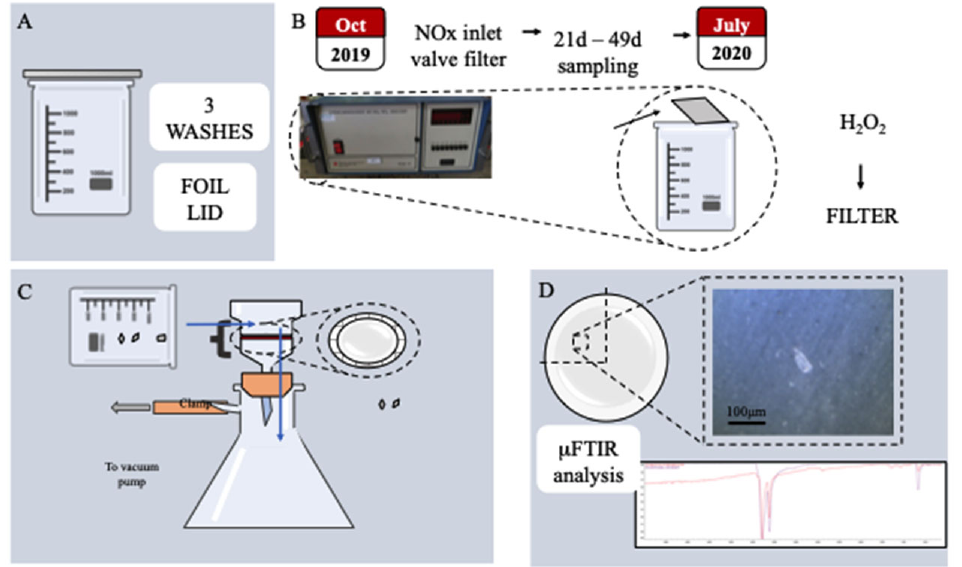
Figure 2. Schematic overview of the MP sampling procedures: ( A ) Glassware preparation, ( B ) NOx inlet valve filter capture of all particulates and digestion, ( C ) Filtration of remaining particles onto Anodisc filters, ( D ) µ FTIR characterization of particles using a polymer spectra